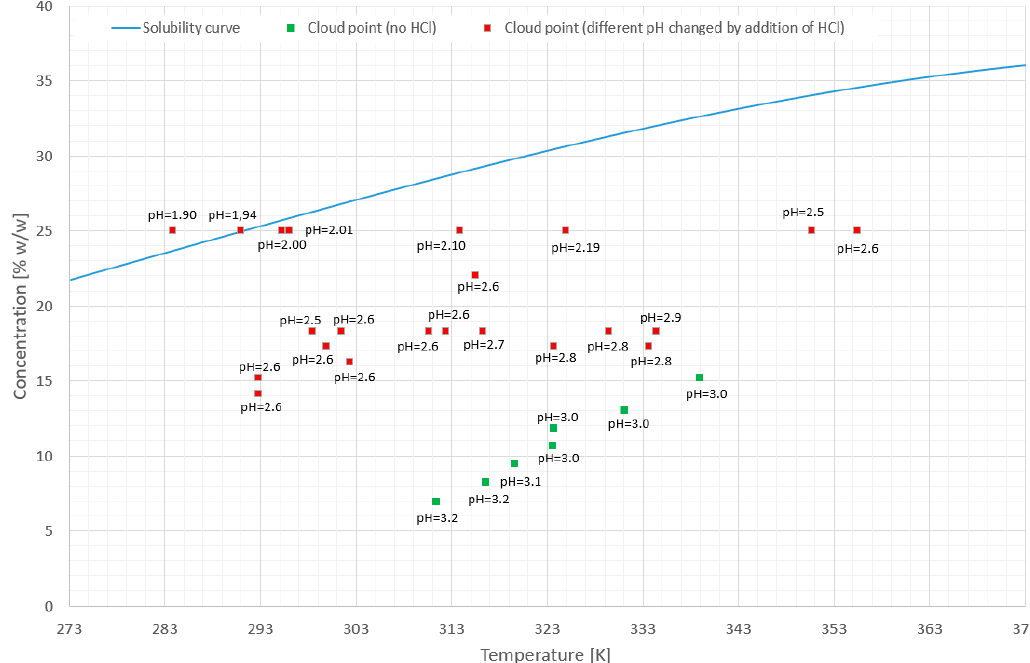
ff erent pH CP of L1 at di